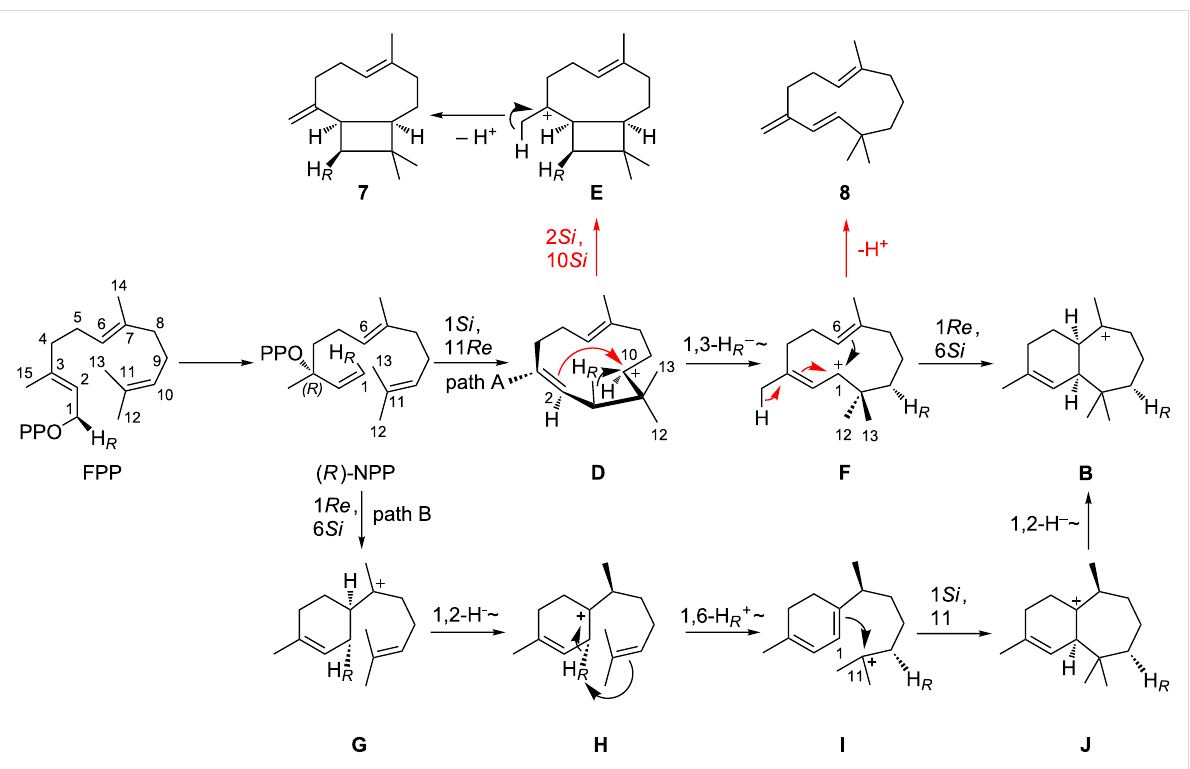
Scheme 3: Proposed cyclisation mechanism towards cation B via an initial 1,11-cyclisation (path A) and an hypothetical alternative mechanism via an initial 1,6-cyclisation (path B). Alternative mechanistic and reaction arrows belonging to branching points are shown in red.